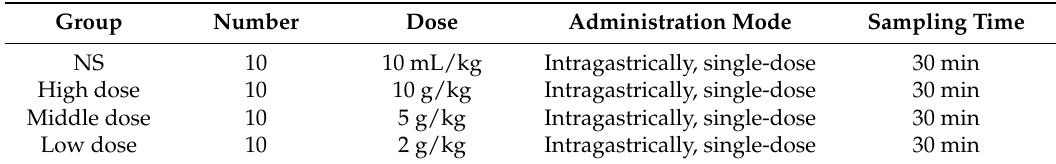
Table 5. Group, dose, administration mode, and sampling time of